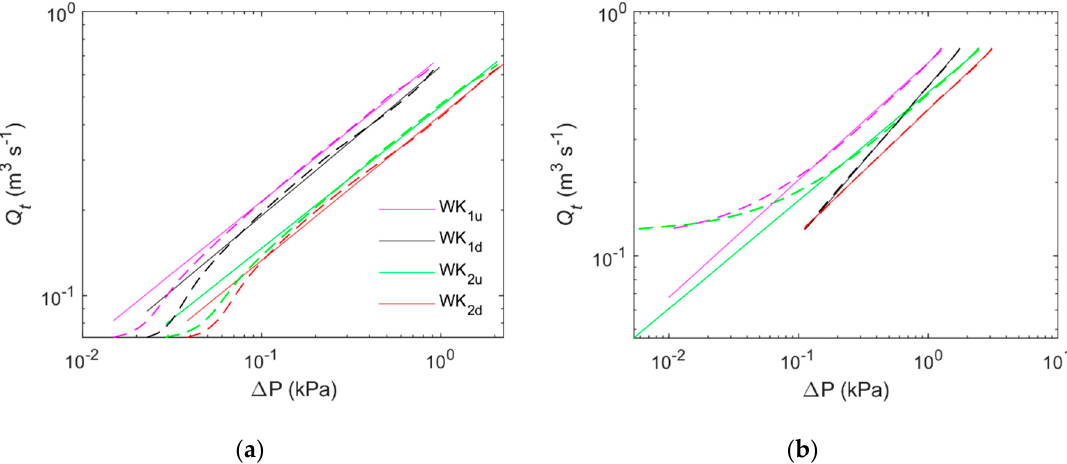
Figure 12. Evolution of the pressure di ff erence ∆ P with the flow rate during transient for four WK configurations at θ = 101 ◦ , shown by the dashed lines. The continuous straight lines show the curves fitted with Equation (1) and the fitted values are presented in Table 4. ( a ) Acceleration and ( b ) deceleration. The legends are provided in figure (a). Table 4. WK coe ffi cient K WK and exponential n from curve fitting in Figure 12. R -squared ( R 2 ) values in the table show a good fit for the data.